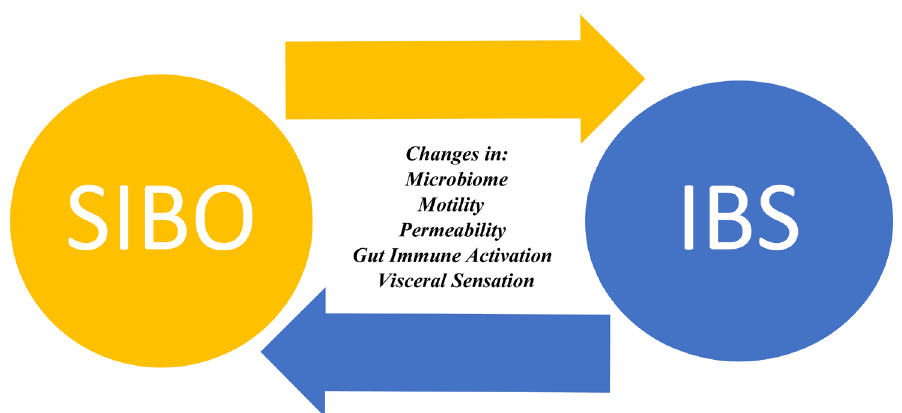
Figure 2. Small intestinal bacterial overgrowth: the chicken or the egg? IBS, irritable bowel syndrome; SIBO, small intestinal bacterial